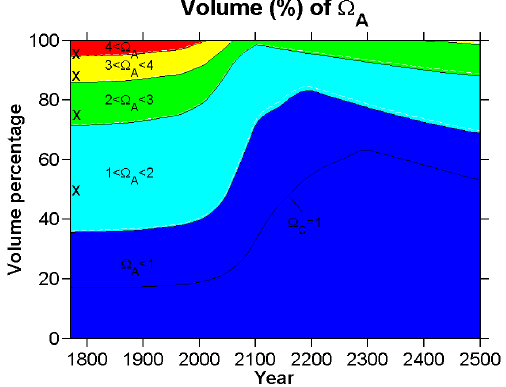
Fig. 13. Simulated global annual mean changes in the entire ocean volume of supersaturated (light blue to red) and undersaturated (blue) waters with respect to aragonite for the High emission com- mitment scenario where emissions are set to zero after 2100. Differ- ences are small between the versions with (color, black contours), and without (white contours) CaCO 3 production depending on satu- ration. The black dashed line indicates the separation between over and undersaturated water with respect to calcite. The crosses de- note the respective volumes of pre-industrial saturation state derived from the GLODAP data set.